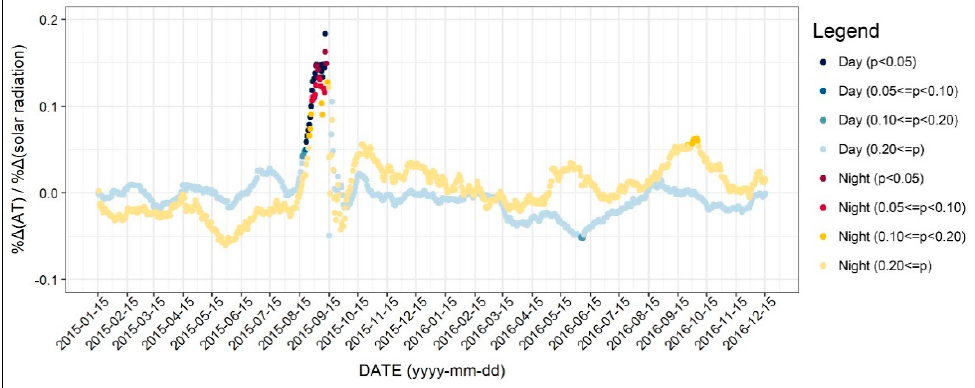
Figure 7. Changing patterns in the regression coefficients and their significances (solar radiation).